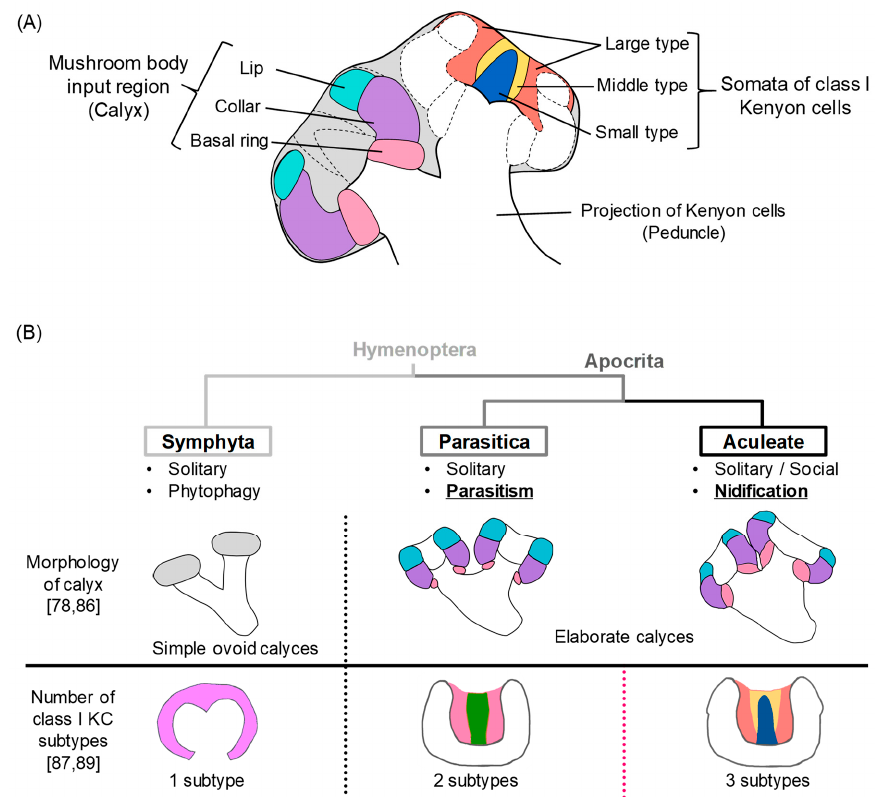
Figure 2. A summary of the comparative analyses of mushroom bodies (MB) in hymenopteran insects. ( A ) Schematic drawings of the components of honeybee MBs. The subcompartments of the input region of the MB are illustrated in the left (lateral) calyx. Class I KC subtypes whose somata are located inside of the MB calyx are illustrated in the right (medial) calyx. ( B ) A simple phylogenic tree for the three major groups in Hymenoptera: Symphyta, Parasitica, and Aculeata (top part), and the structural characteristics of the MBs of the corresponding species (middle and bottom parts). The elaborate MB calyces are observed in Apocrita, but not in Symphyta. On the other hand, the number of class I KC subtypes increased from one in Symphyta to two in Parasitica, and three in Aculeata. Figures in the middle part are cited from [86], and figures in the bottom part are cited from [88], with some